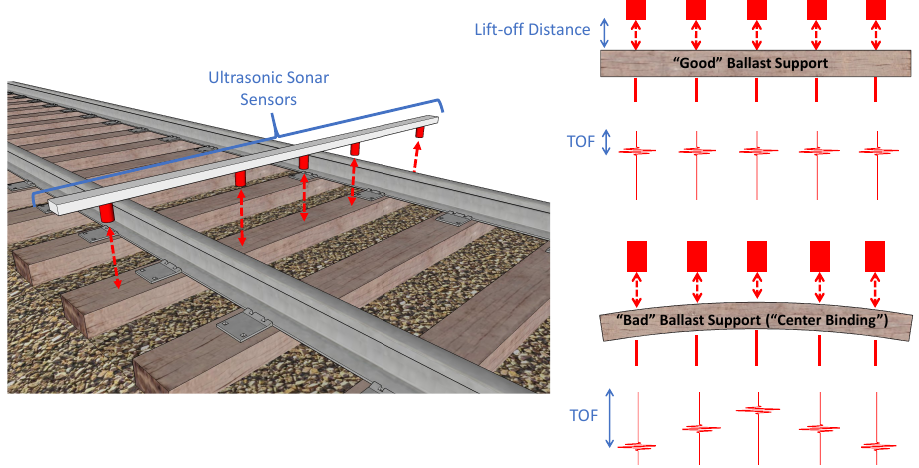
Figure 2. Concept of ultrasonic ranging for measuring the vertical deflection of a tie using time-of- flight